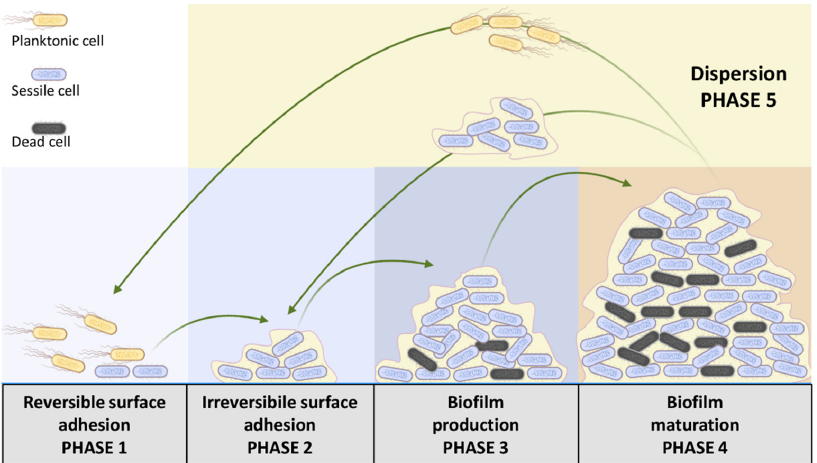
Figure 2. Schematic representation of cyclic biofilm formation, from reversible adhesion of bacteria to biofilm dispersion, consisting of the evacuation of matrix–bacteria aggregates.